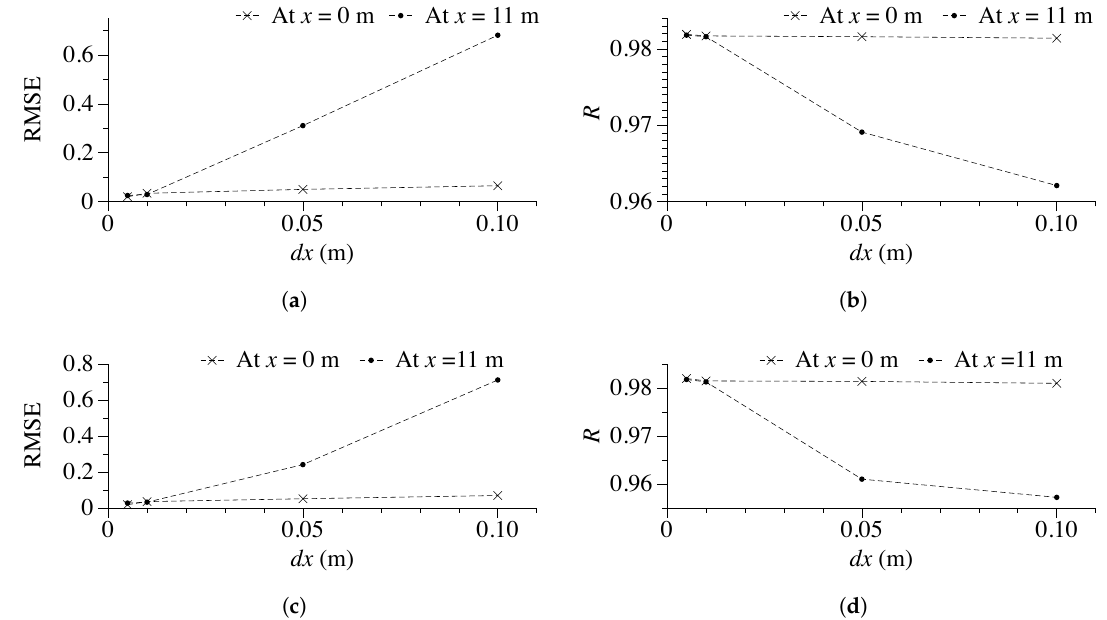
Figure 4. Comparison of accuracy between the numerical and experimental wave signal with different grid sizes dx for ( a ) case A (RMSE for wave phases); ( b ) case A ( R ); ( c ) case B (RMSE for wave phases); ( d ) case B ( R